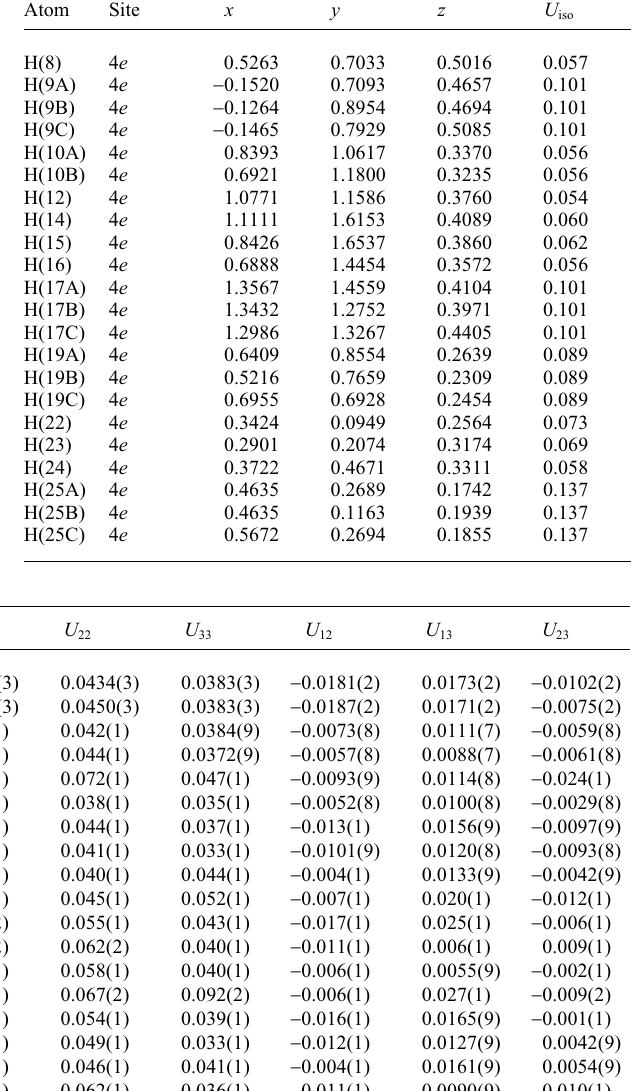
Table 2. Atomic coordinates and displacement parameters (in Å 2 ) .